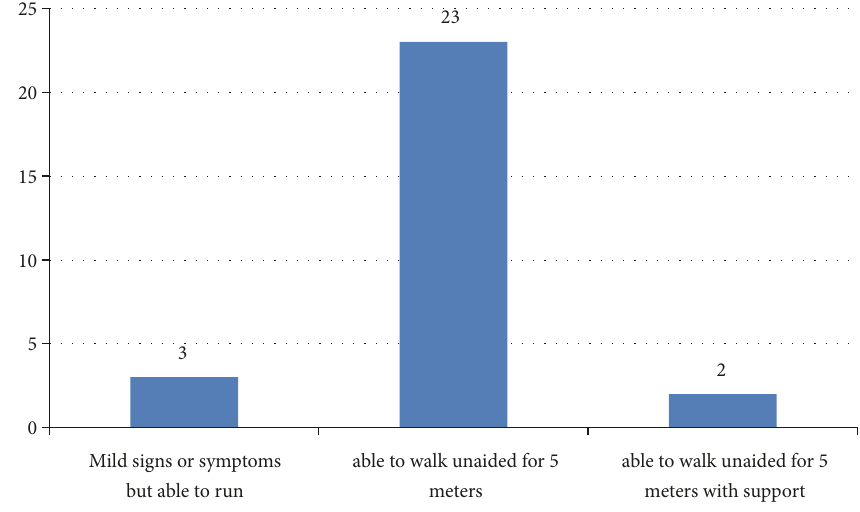
Figure 3: Hughes functional outcome of patients with Guillain-Barre syndrome (n: 28). Table 3: Baseline characteristics of patients with Guillain-Barre syndrome (n: